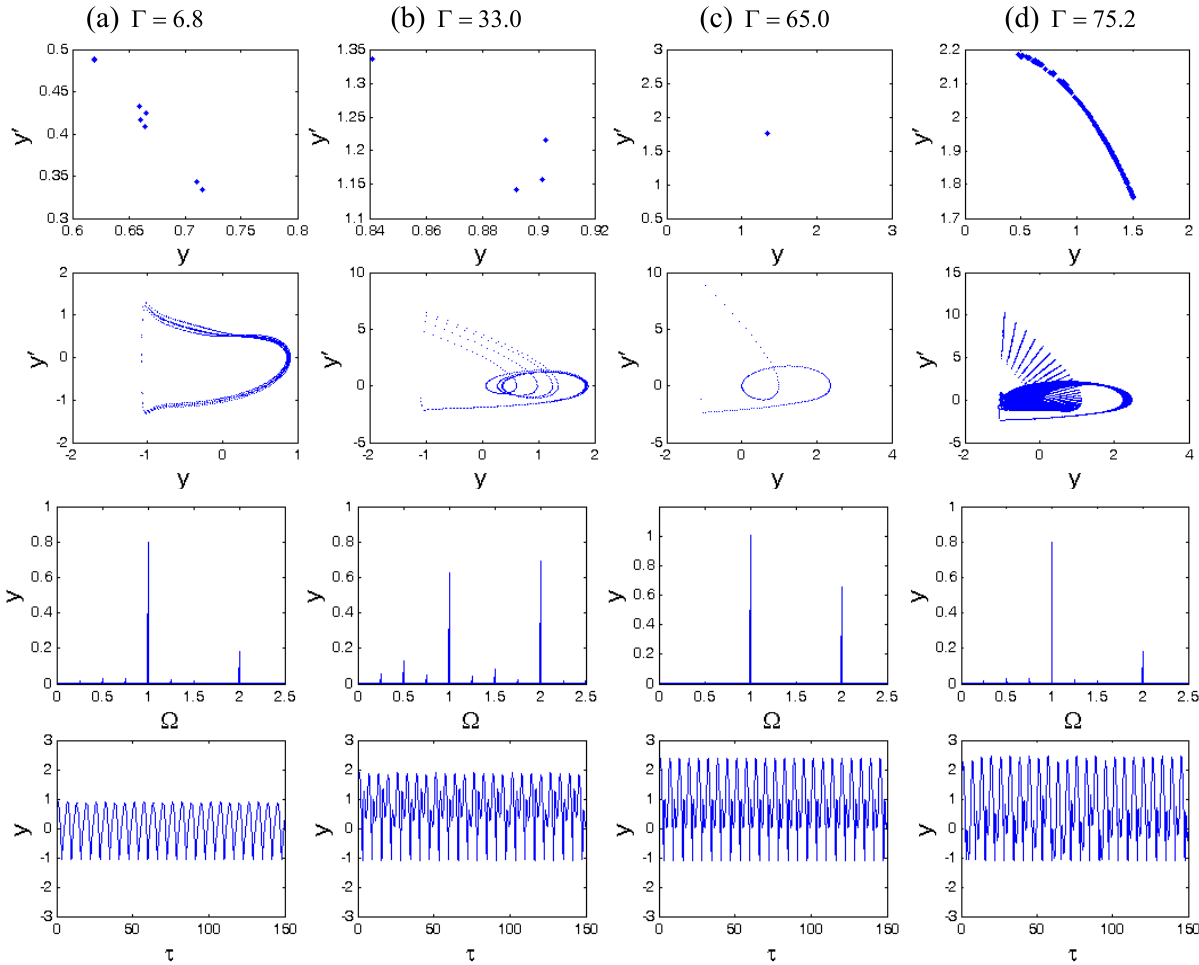
Figure 5. The Poincaré maps, phase portraits, amplitude spectrums and time histories of different Γ